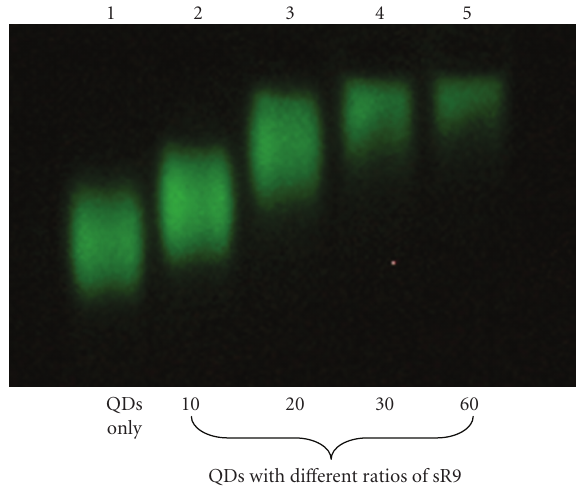
Figure 1: Gel retardation analysis of the interaction between QDs and SR9. QDs were premixed with SR9 at di ff erent molecular ratios. Lane 1: QDs without SR9. Lanes 2–5: QDs mixed with SR9 at ratios of 10, 20, 30, and 60, respectively. The decrease in mobility reflected the formation of QD/SR9